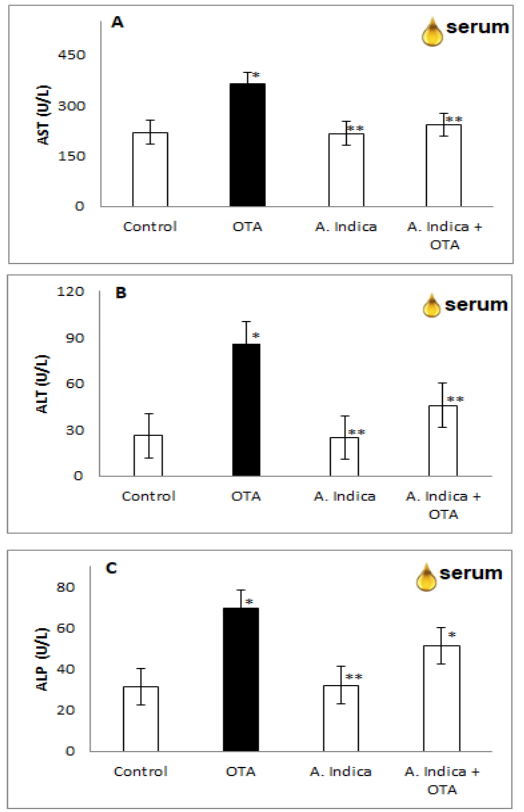
Figure 2. Levels of hepatic enzymes AST ( A ), ALT ( B ), ALP ( C ) measured in serum of mice ( n = 6) on a diet included: OTA alone, A. indica oil, and combination of A. indica oil + OTA compared to the healthy controls; * p <0.05 vs. control group; ** p < 0.05 vs. OTA